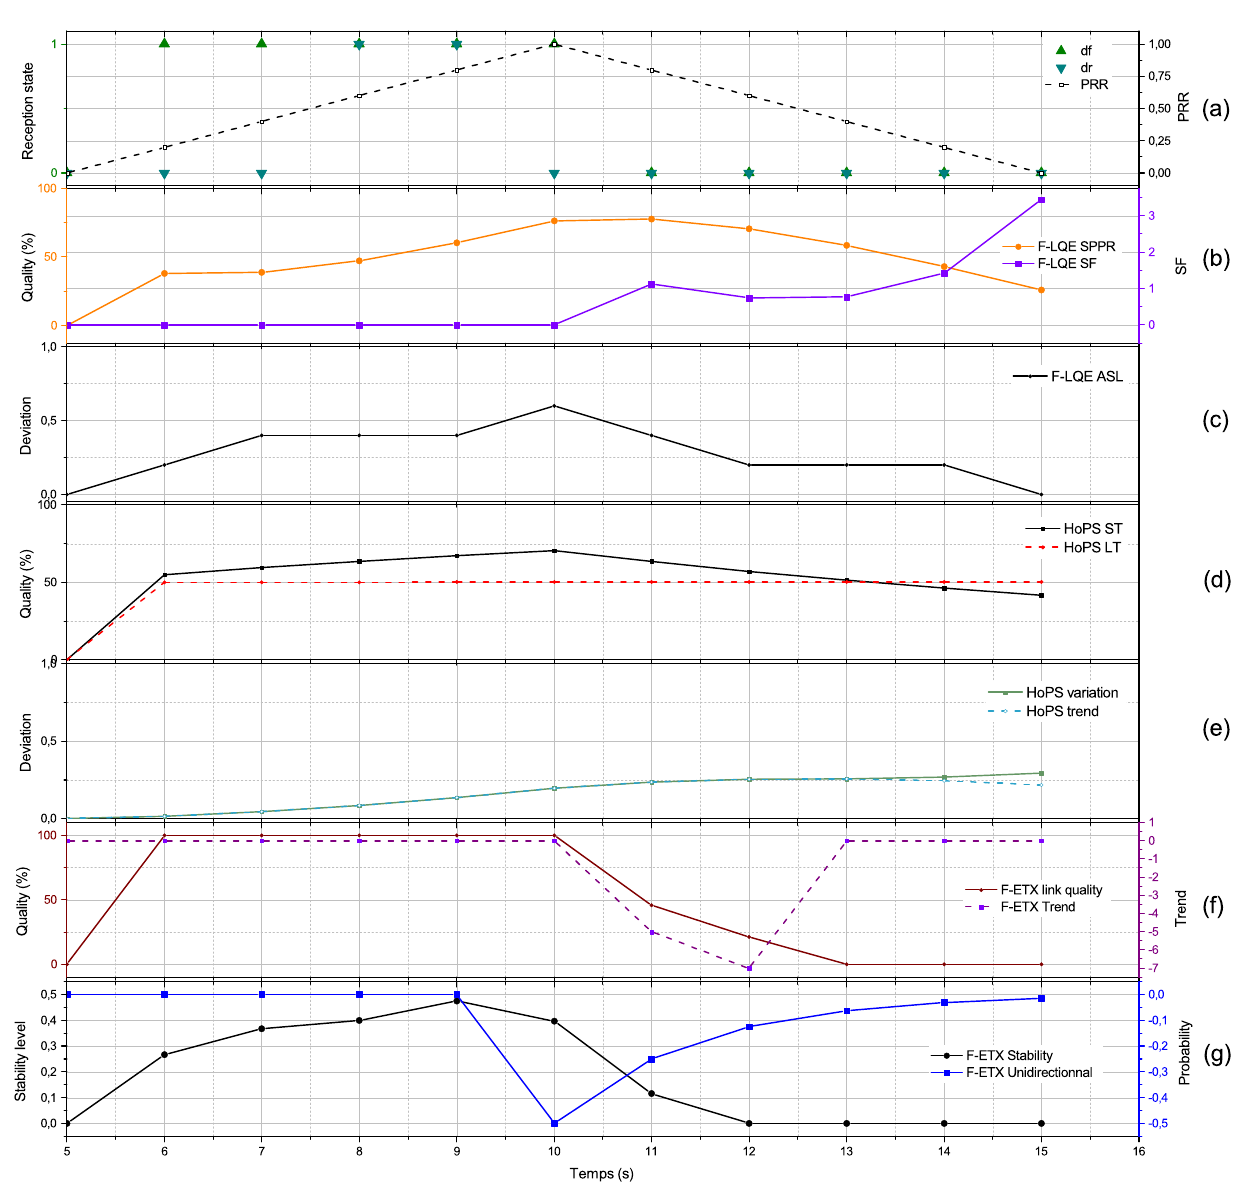
Figure 9. Fast speed